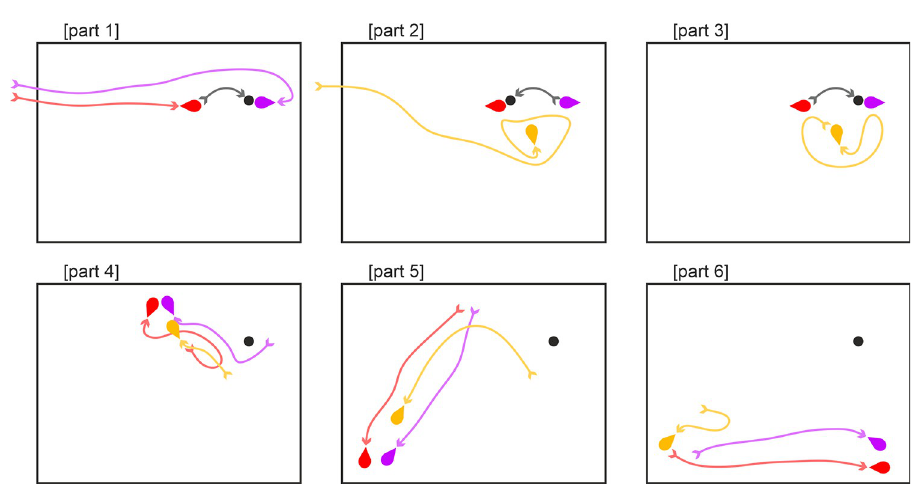
Fig 3. Schematic representations of the experiment characters interacting in the priming video of Experiments 2, 3 and 5. In this example, the round end of the teardrop is the leading edge of the motion direction and perceived as the face. The arrow headed lines were not present in the video and are shown here only to illustrate movement. Note that the characters (shown here as red, purple and yellow teardrop shapes) differed in Experiment 5 (see appropriate section). Part 1: Purple and Red enter the scene, approach the black ball then toss it back and forth. Part 2: Yellow enters the scene, approaches Purple and Red but receives no response. Part 3: Purple and Red toss the ball back and forth then Yellow reproaches each of them. Part 4: Purple and Red move away then Yellow pursues. Part 5: Again, Purple and Red move away then Yellow pursues. Part 6: Purple and Red move away, yellow considers following but then slowly moves away. Full video at